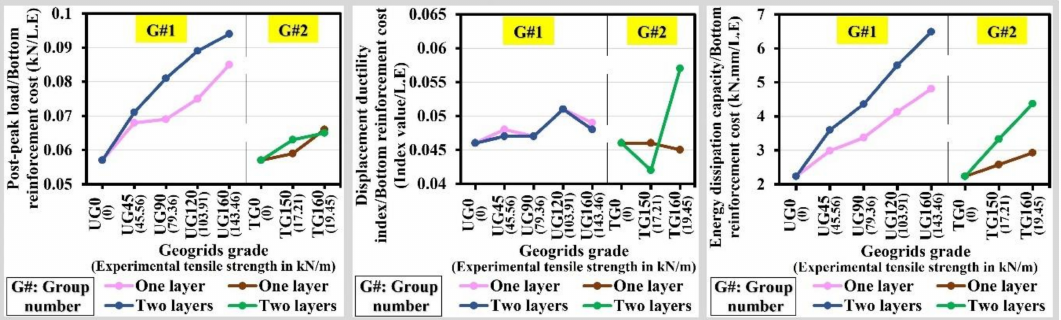
Figure 20. Geogrids utilization benefit to cost